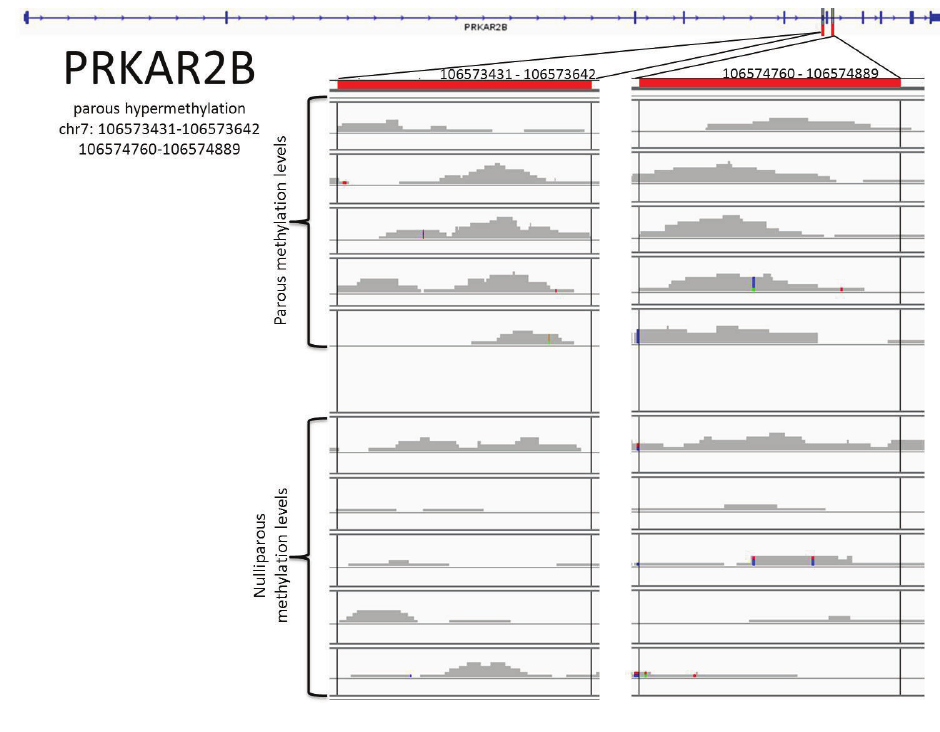
Table 2. DMRs within parous hypermethylated